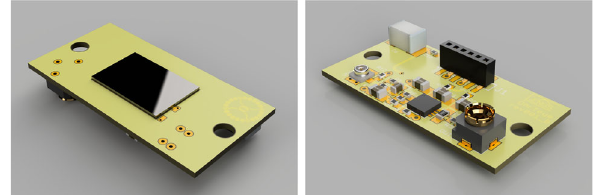
Fig. 3 The photo-detectors lodge a 1 cm 2 SiPM with a low noise cryo- genic amplifier in a single 15 × 30 mm 2 board 15 sl/min with a consumption of about 40 sl/min of nitrogen gas. Fig. 4 CorrelatednoisesfortheNUV-HD-CryoSiPMat77Kasexcess